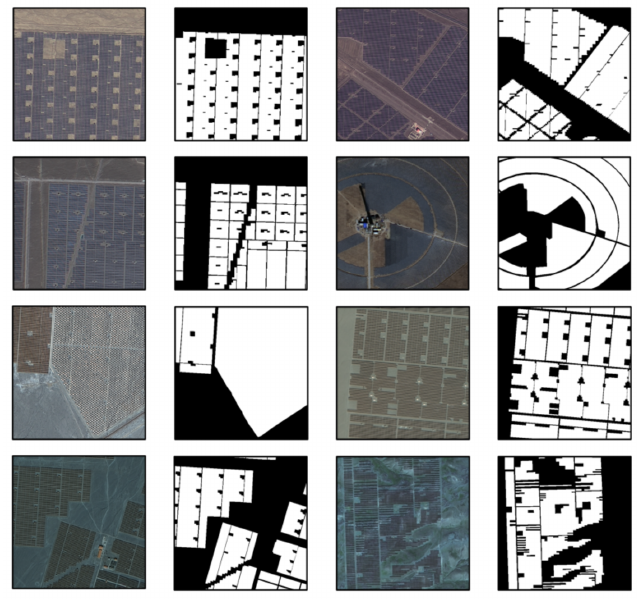
Figure 4. Semantic segmentation dataset display.